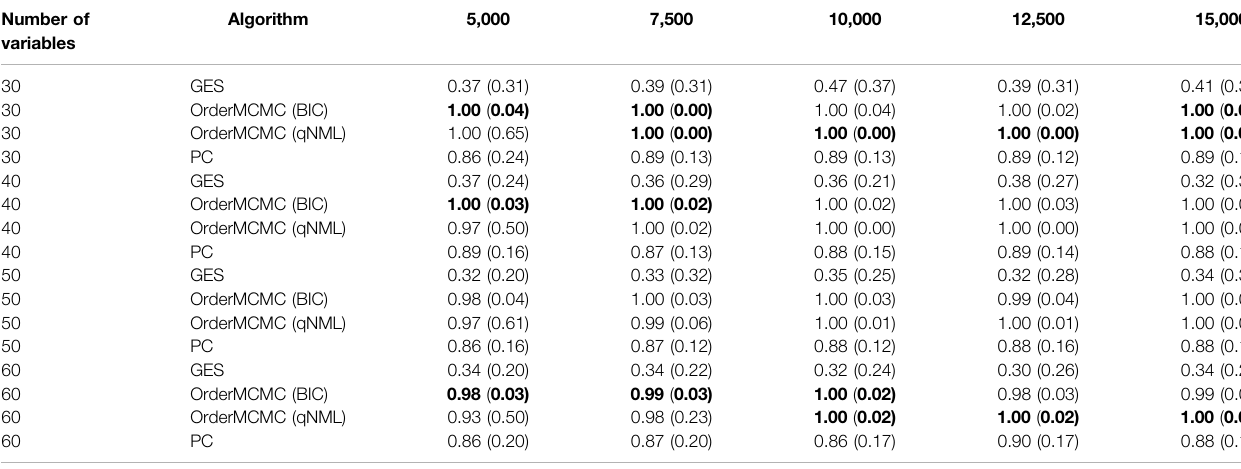
TABLE 4 | Pivot Table of V-structure precision. Rows stratify by number of variables. Columns are over samples size. V-structure Precision performance is provided as: Median (IQR) . Highest precision in each sample/variable combination is in bold. Number of Algorithm variables